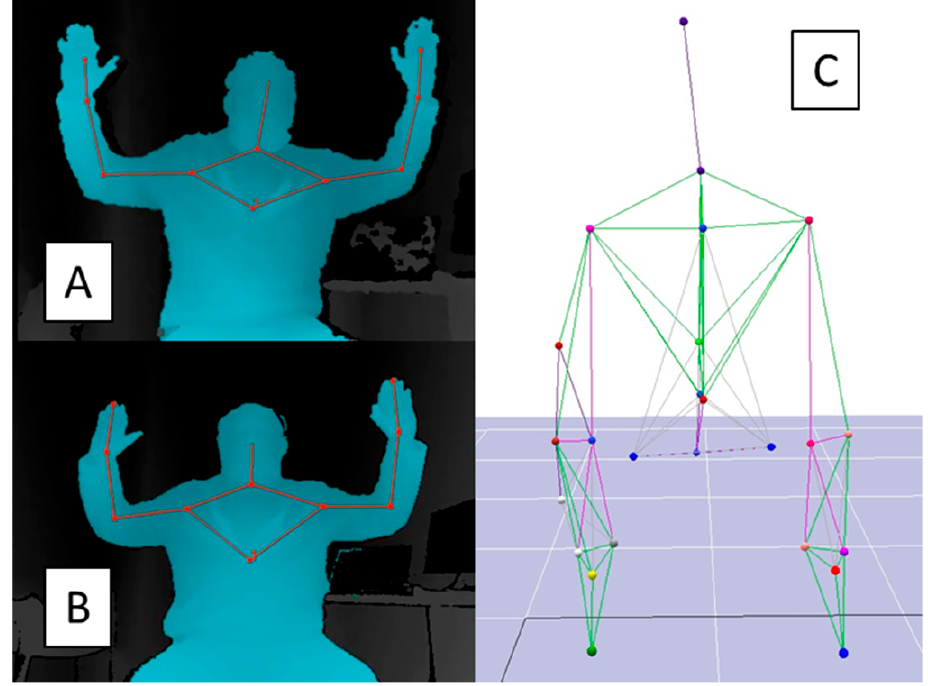
Figure 2. Examples of the kinematic body landmarks measured by the K1 ( A ), K2 ( B ), and VMC ( C ). The K1 and K2 measured 11 body landmarks. The VMC measured the position of 25 body landmarks.